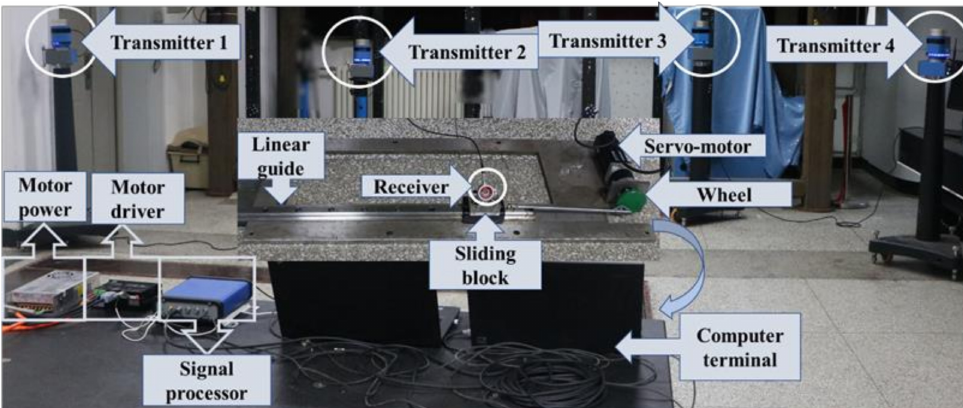
Figure 3. Hardware used in the experiments containing the experimental device and the wMPS system. A receiver was installed on top of the sliding block of the oscillation device. The wMPS stations were set in nearby